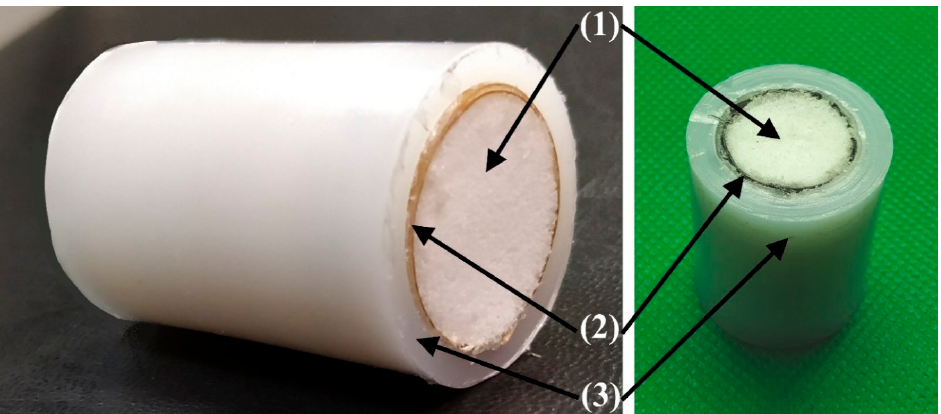
Figure 7. Multi-UHMWPE forms composite of porous UHMWPE ( 1 ), armored layer of highly